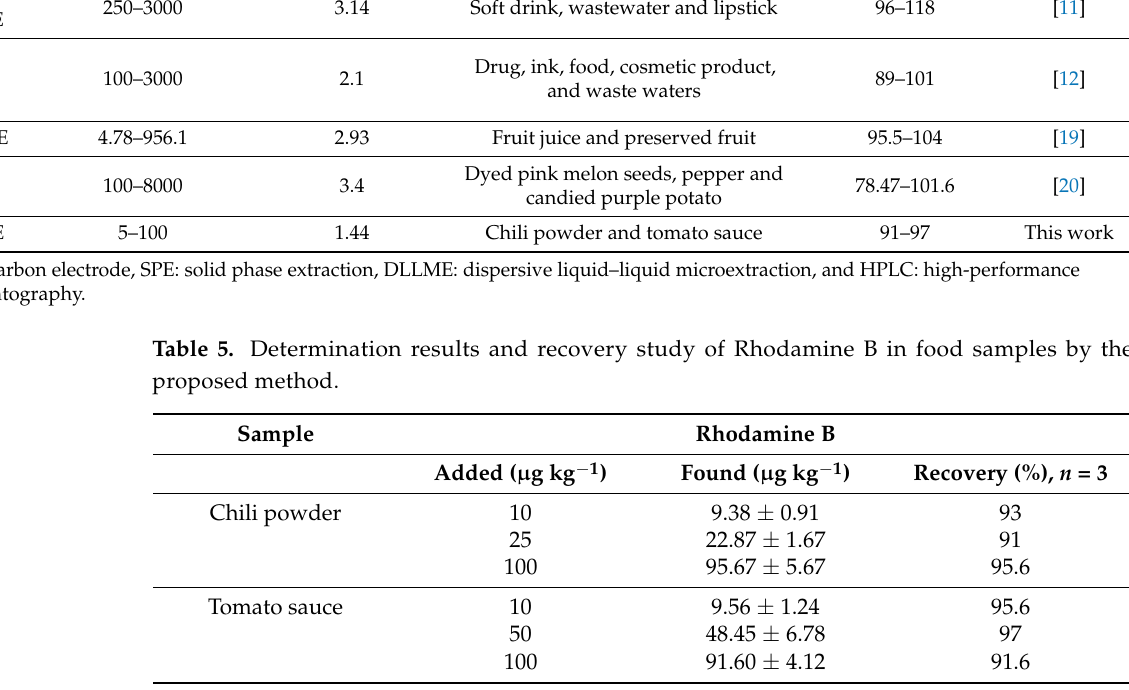
Table 4. Comparison of the proposed method for determination of Rhodamine B with other reported methods. Method